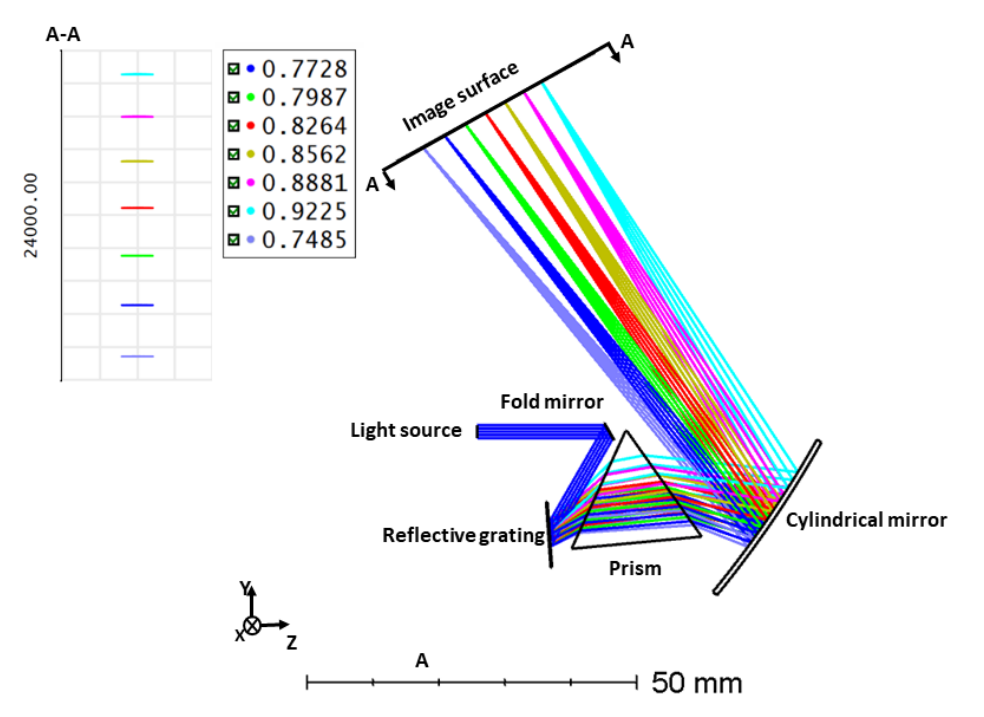
Figure 8. Wavenumber linear all-reflective spectrometer.